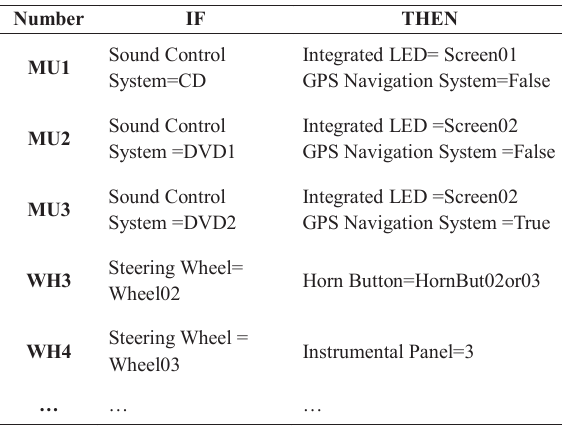
Table 2. Partial Constraint of